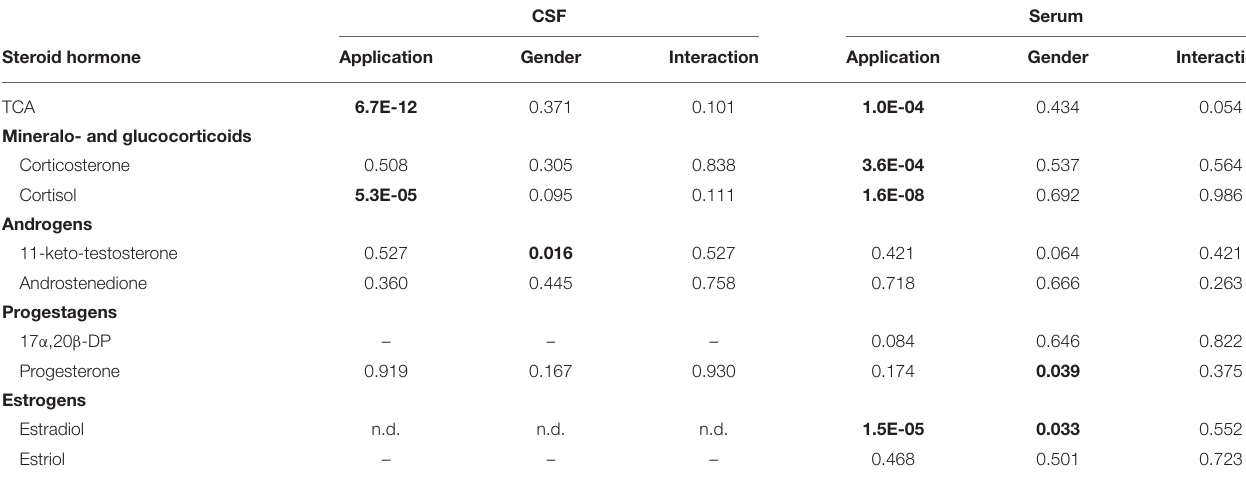
The table provides p-values for the main and interaction effects of drug application and gender as calculated using linear models adjusted for treatment cycle. Statistically significant effects (p < 0.05) are indicated in bold. –, not detected; 17 α ,20 β -DP, 17 α ,20 β -dihydroxy-4-pregnen-3-one; CSF, cerebrospinal fluid; MS, multiple sclerosis; n.d., not determined; TCA, triamcinolone